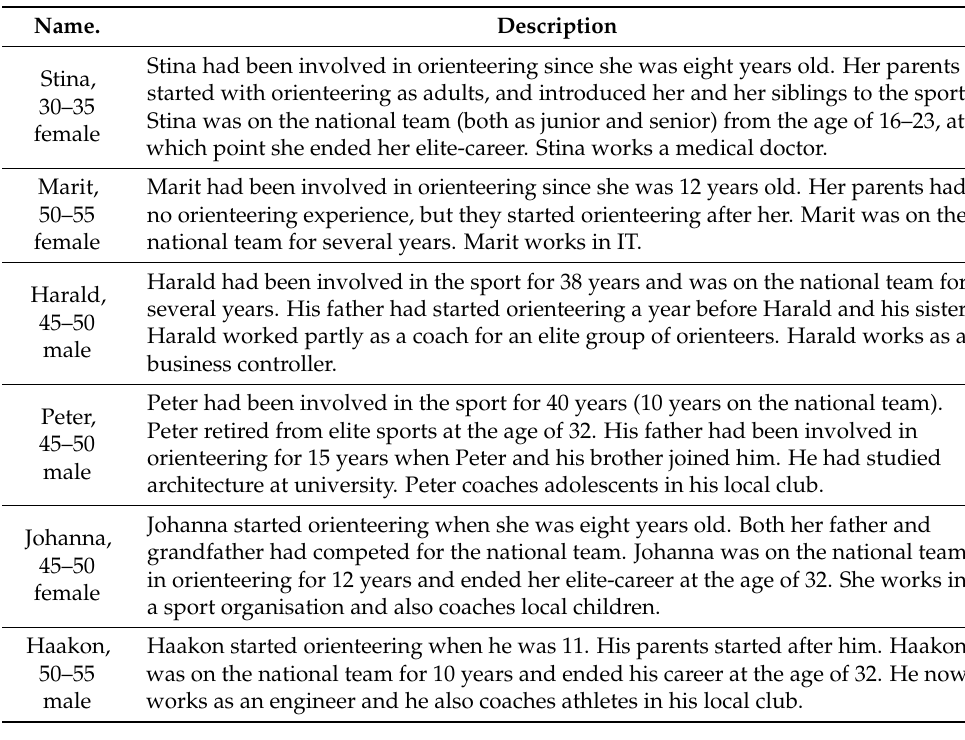
Table 1. Description of the